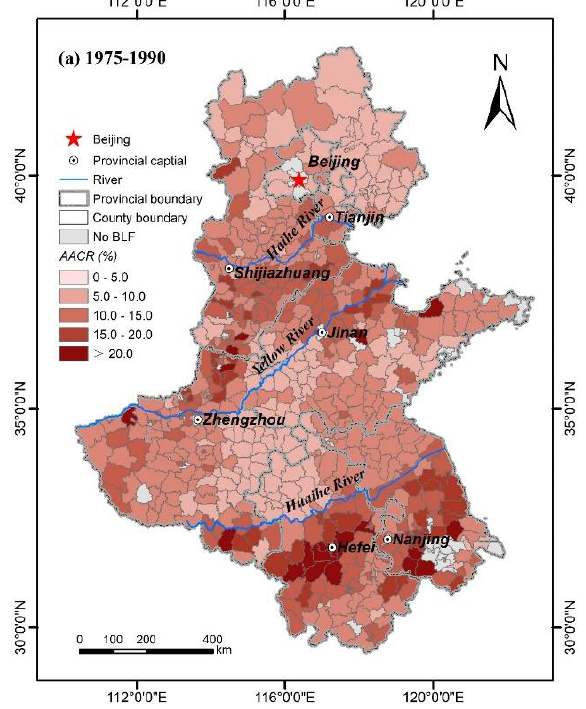
Table 3. Dynamics of the built-up land in floodplains (BLF) in different